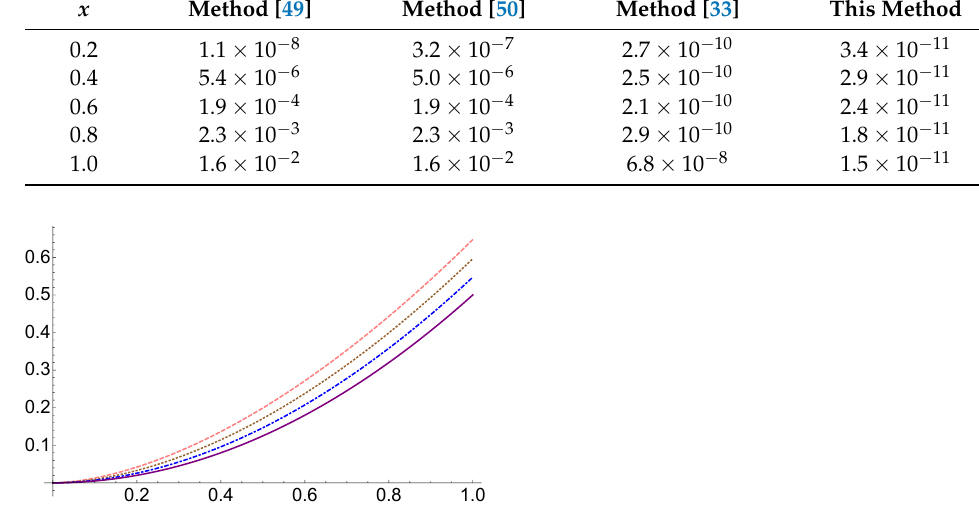
Figure 4. f ( x ) , where q = 0.7 (dashed), q = 0.8 (dotted), q = 0.9 (dashed-dotted), and exact solution q = 1 (continuous), with α = 0.5, for Example